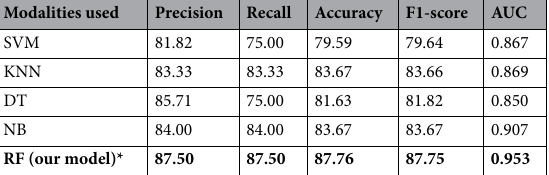
Table 7. Comparison of different classifiers ( MS 2 test dataset ; Second Layer). Asterisk ( *): is the model with the best predictive